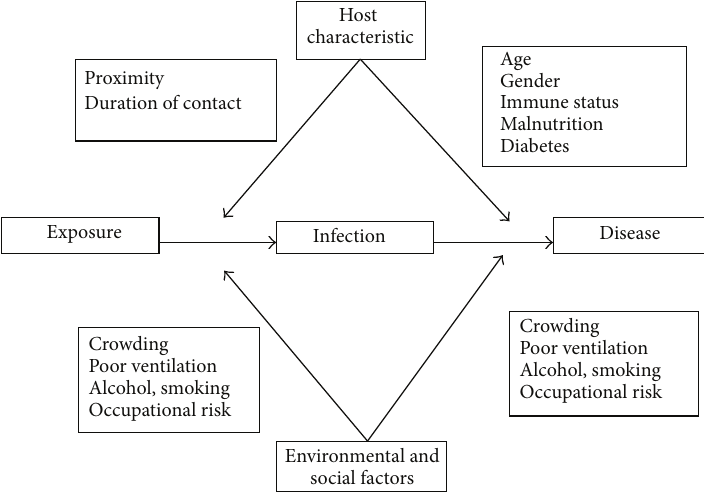
Figure 1: Risk factors for Tuberculosis infection and